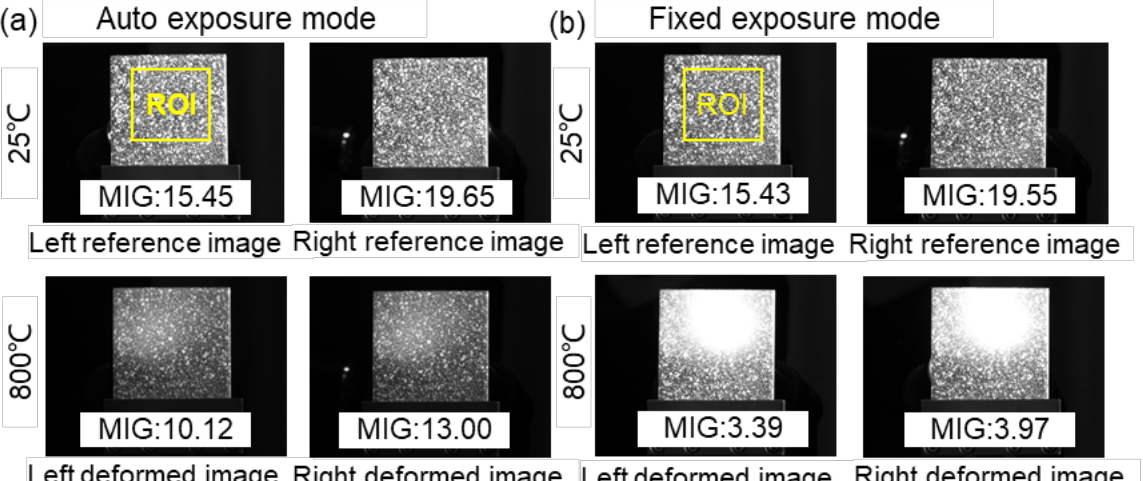
Figure 10. Reference (25 ◦ C) and deformed (800 ◦ C) images obtained by ( a ) auto exposure mode and ( b ) fixed exposure mode.